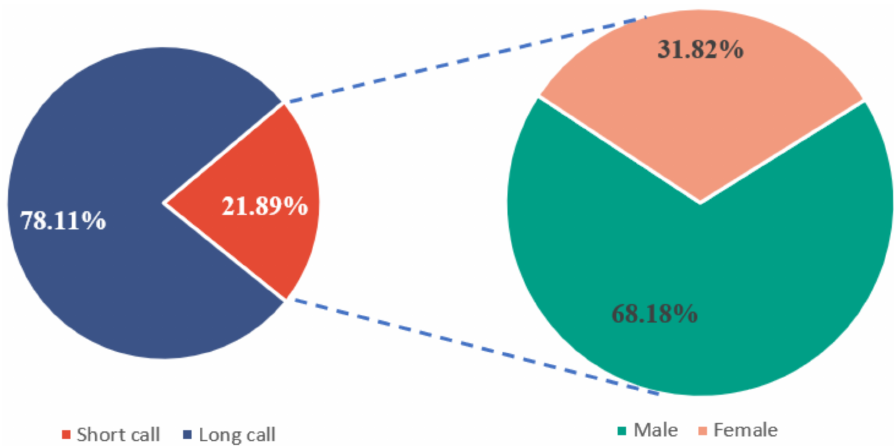
Figure 2. The proportion of males is higher for long calls, while the proportion of females is higher for short calls. Through further statistical testing ( p < 0.05), it was found that there was a significant difference in long and short calls between the